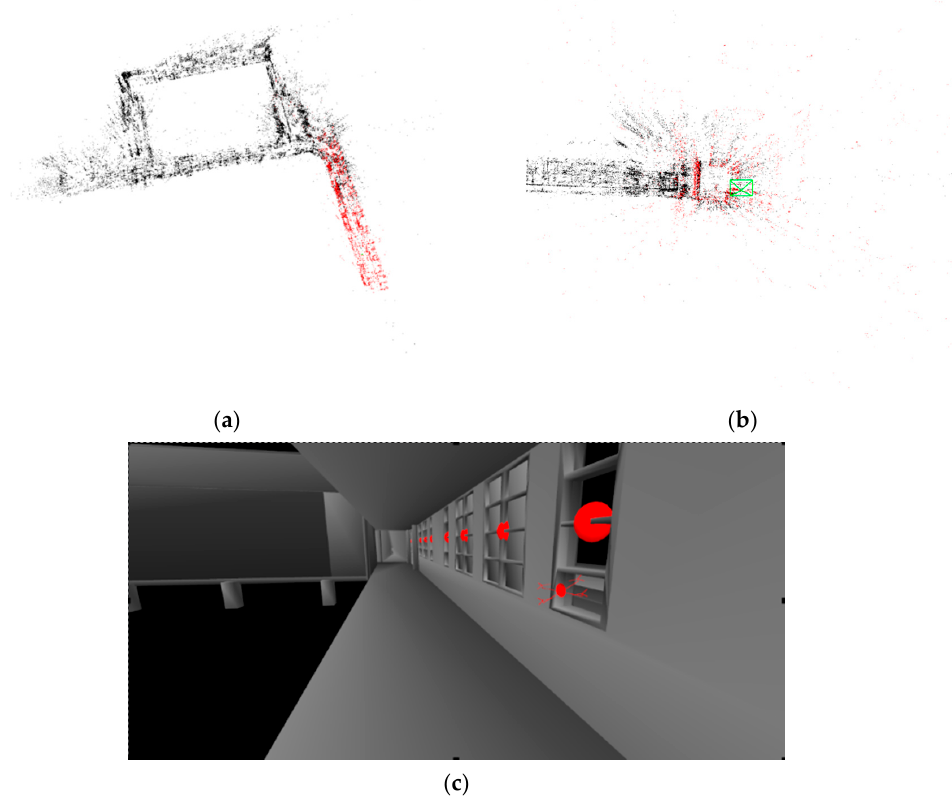
Figure 15. Re-localization of the UAV in previously constructed map. The previously constructed map is shown in ( a ). The UAV is shown localized in this map in ( b ) while ( c ) shows its representation in 3D CAD model.